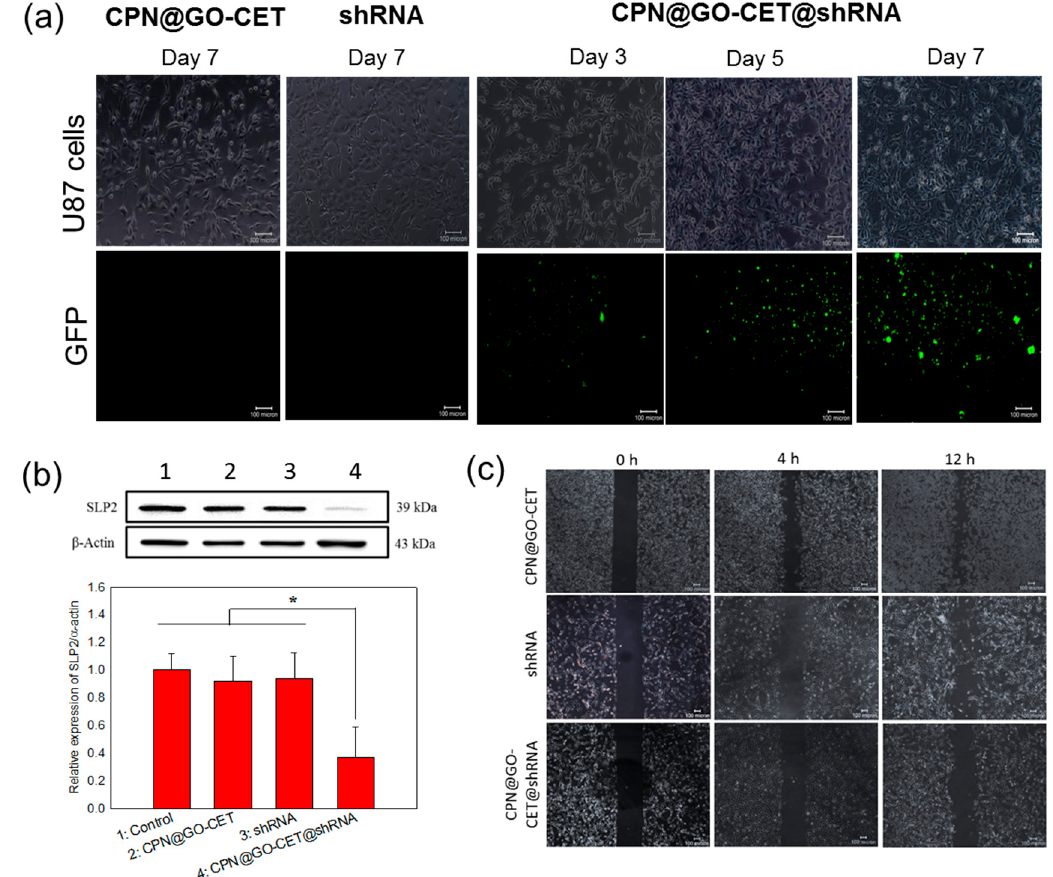
Figure 8. Transfections of U87 cancer cells with CPN@GO-CET@shRNA could knockdown SLP2 gene expression and inhibit cancer cell migration. ( a ) The transfection efficiency was determined from green fluorescent protein (GFP) expression with the fluorescence images shown below the corresponding bright-field images (bar = 100 μ m). The effects of SLP2 shRNA on SLP2 expression level in U87 cells were examined by Western blot analysis using β -actin as a loading control ( b ) and wound-healing assays for cell migration ability (bar = 100 μ m) ( c ) after U87 cells were transfected with CPN-GO-CET, shRNA and CPN@GO-CET@shRNA for 5 days. * p < 0.05.